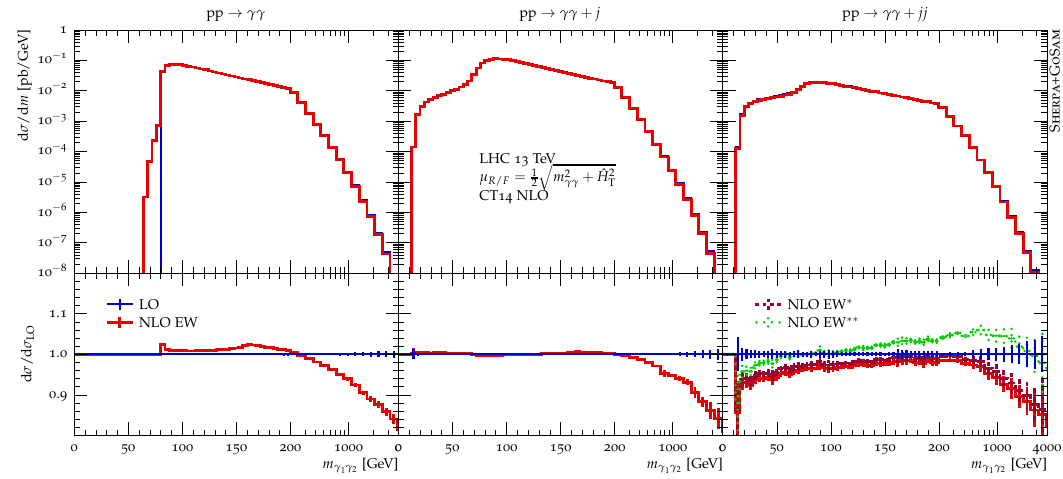
Figure 3 . The invariant mass of the leading and subleading isolated photons in (cid:13)(cid:13) + 0 ; 1 ; 2 jets production at 13 TeV at the LHC. Note that above 200 GeV the x -axis is given as a logarithmic